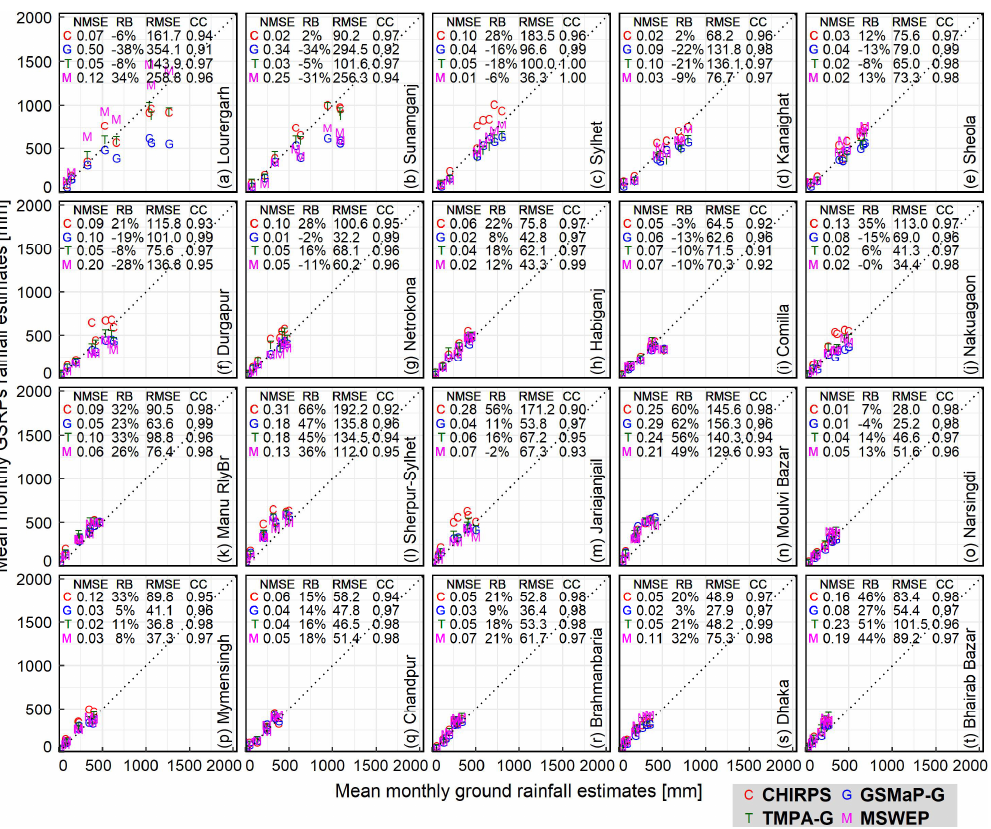
Figure 6. Scatterplots of mean monthly accumulated GSRP estimates against the ground rainfall for the wet seasons during the entire study period (2009–2016) at 20 rain-gauge stations ( a – t ). Statistical indices are included inside the plot for each station.